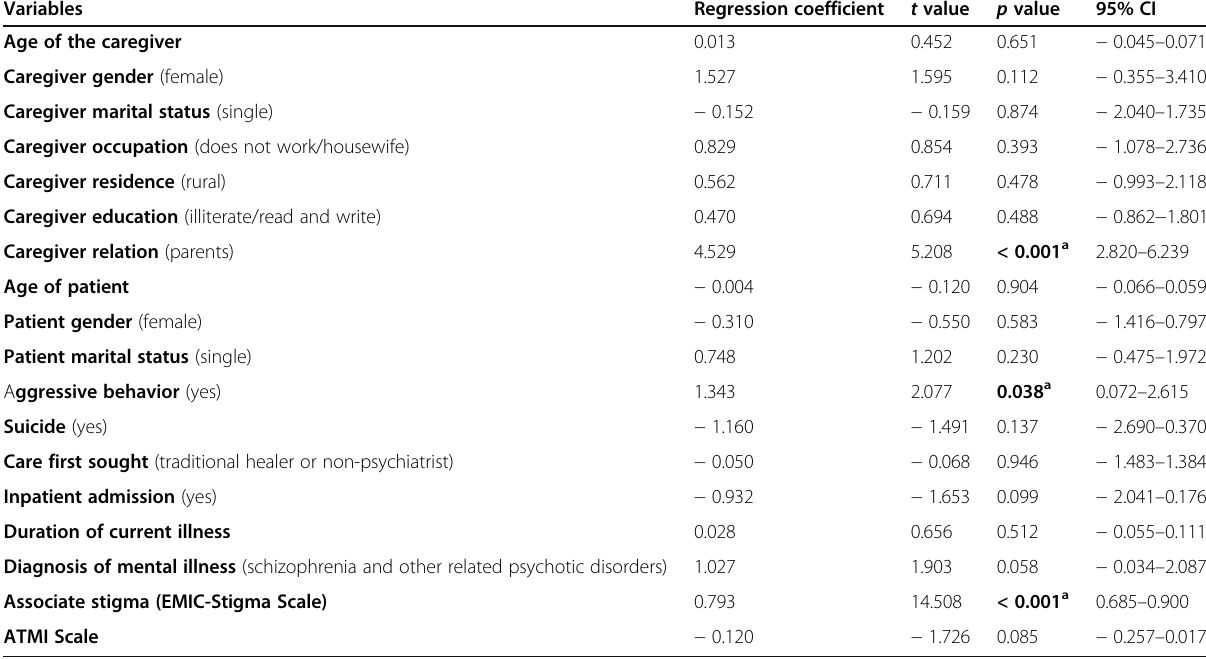
Table 4 Correlates of affiliate stigma among the studied participants at Assiut University Hospital, 2017